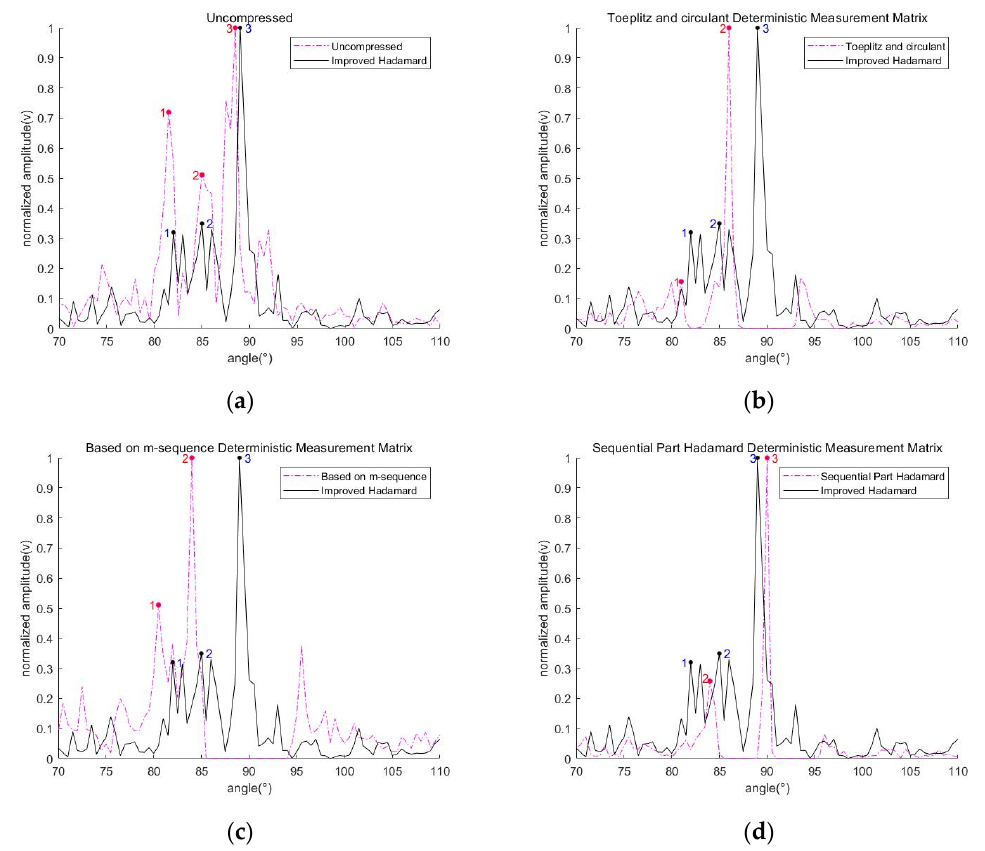
Figure 11. The reconstructed targets with different measurement matrices in 44% compression ratio: ( a ) the reconstructed targets under uncompressed observations; ( b ) the reconstructed targets with Toeplitz and circulant Deterministic Measurement Matrix; ( c ) the reconstructed targets with based on m-sequence Deterministic Measurement Matrix; and ( d ) the reconstructed targets with sequential Part Hadamard Deterministic Measurement Matrix.